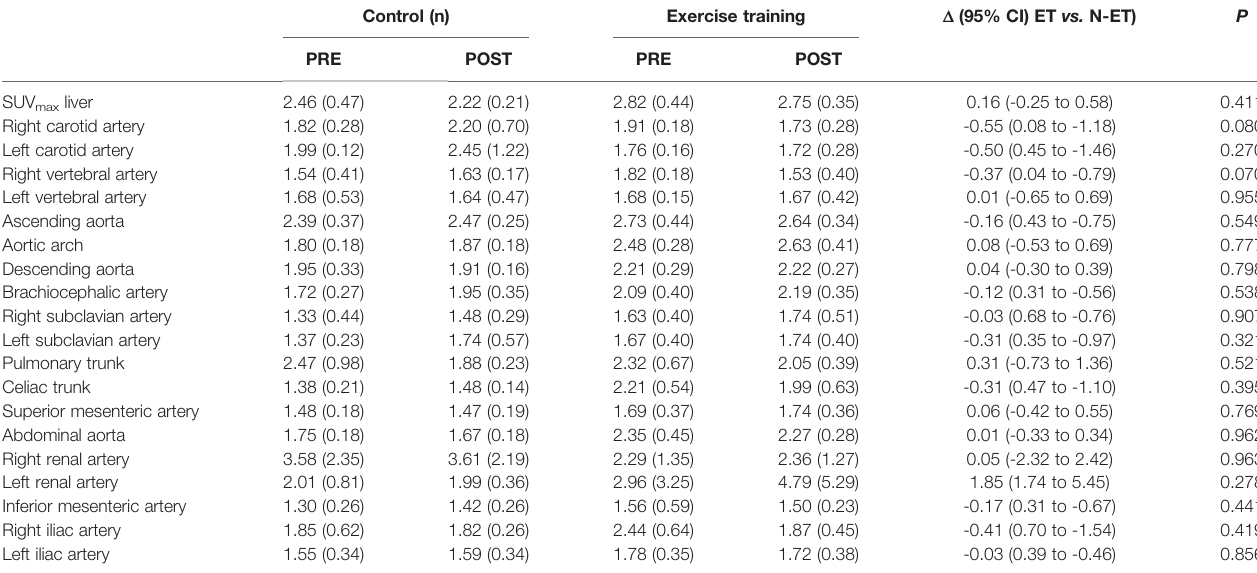
TABLE 3 | Effects of a 12-week, home-based, exercise training program on SUV max , assessed by [ 18 F] FDG-PET/MRI, in childhood-onset Takayasu arteritis patients. Control (n) Exercise training D (95% CI) ET vs. N-ET)